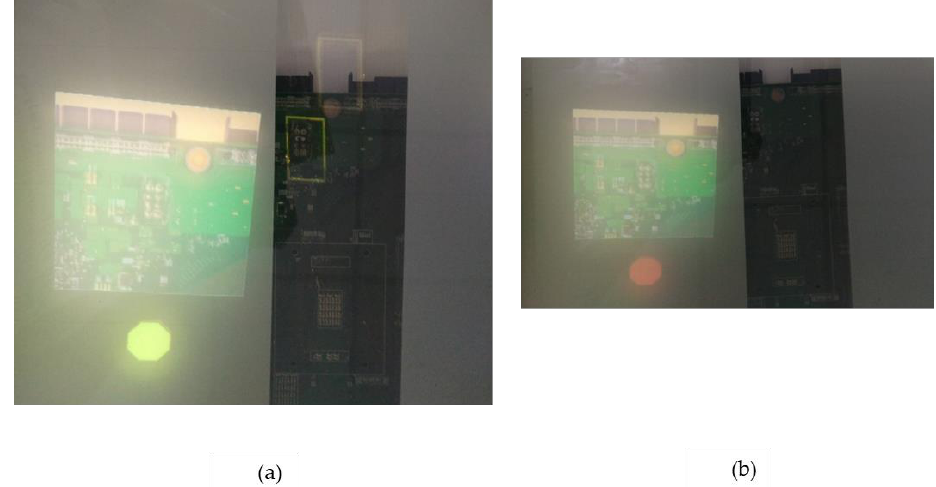
Figure 8. ( a ) Yellow disc appended to reference image. ( b ) Red security disc appended to an image.